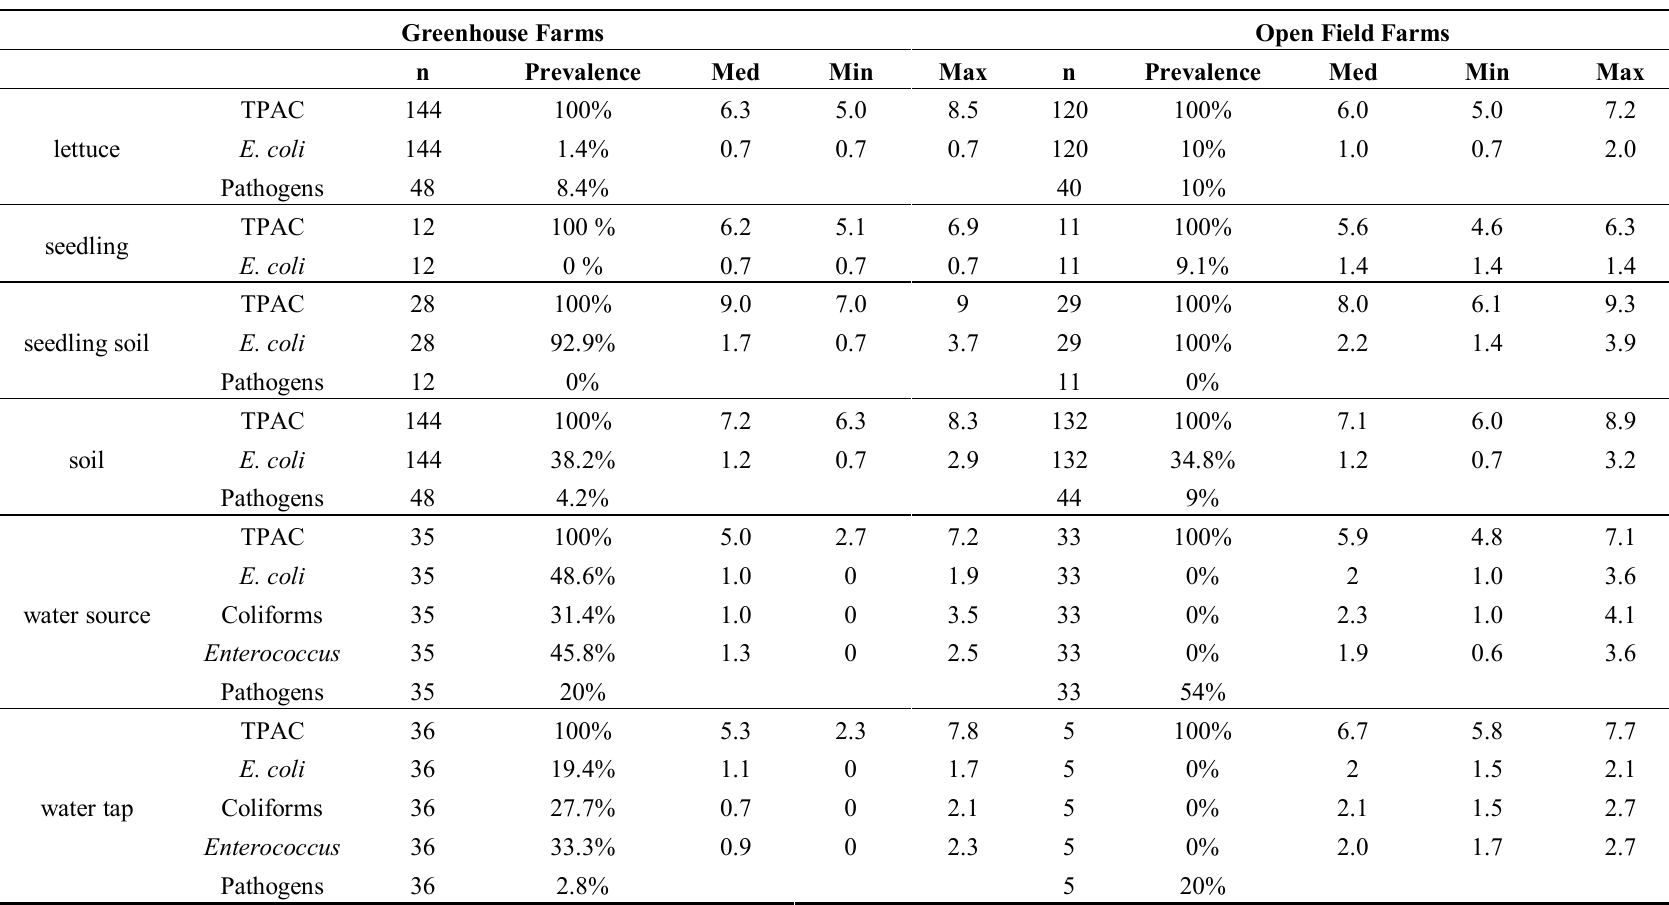
Table 2. Results of greenhouse and open field farms for different microbial indicators isolated from samples in primary production (indicators Total Plate Count [TPAC], E. coli , coliforms, Enterococcus —in log CFU/g for samples of lettuce, soil, and seedlings or log CFU/100 ml for water samples; pathogens Salmonella spp., Campylobacter spp., and EHEC—presence or absence/25 g for samples of lettuce, soil, and seedlings or 1 L for water samples) with n = number of samples. Median, minimum and maximum were calculated from the values above detection limit ( i.e. , E. coli ≥ 0.7 log/g or ≥ 0 log/100 mL, coliforms ≥ 0 log/100 mL, enterococci ≥ 0 log/100